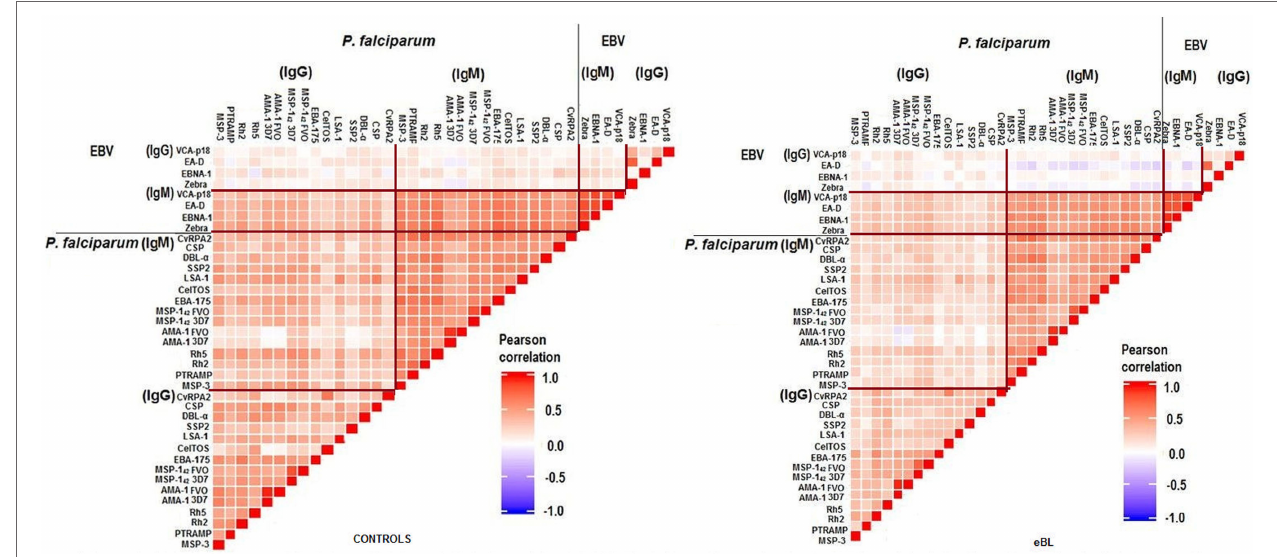
FigUre 2 | Pairwise correlations between logged antibody levels of both